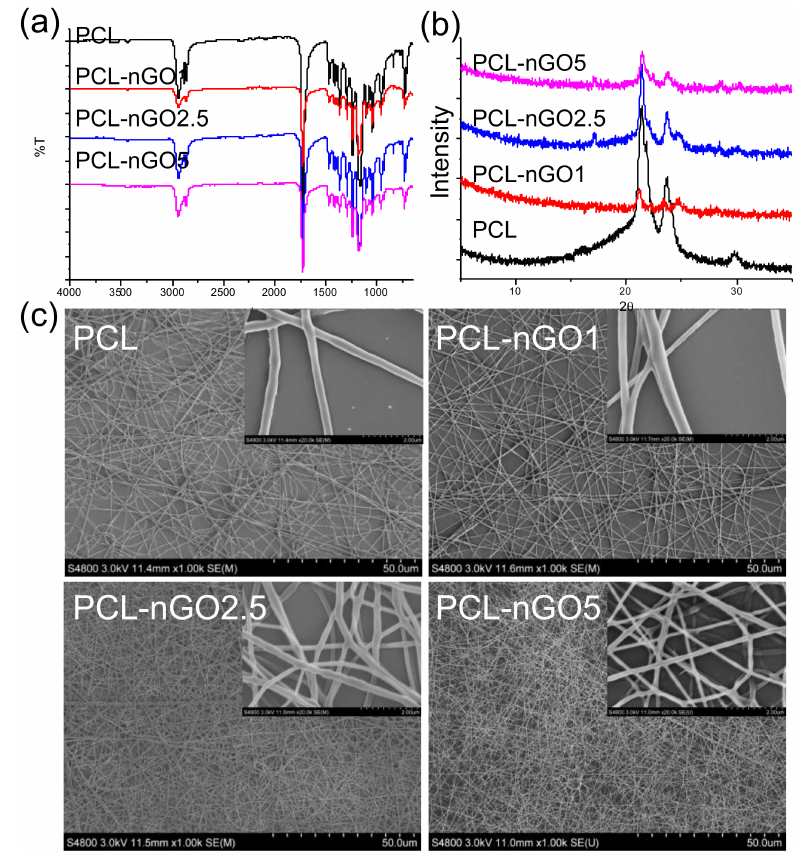
Figure 8. ( a ) FTIR spectra of poly( ε -caprolactone) (PCL), PCL-nGO1, PCL-nGO2.5, and PCL-nGO5 fibers; ( b ) XRD spectra of PCL, PCL-nGO1, PCL-nGO2.5, and PCL-nGO5 fibers; ( c ) SEM images of PCL, PCL-nGO1, PCL-nGO2.5, and PCL-nGO5